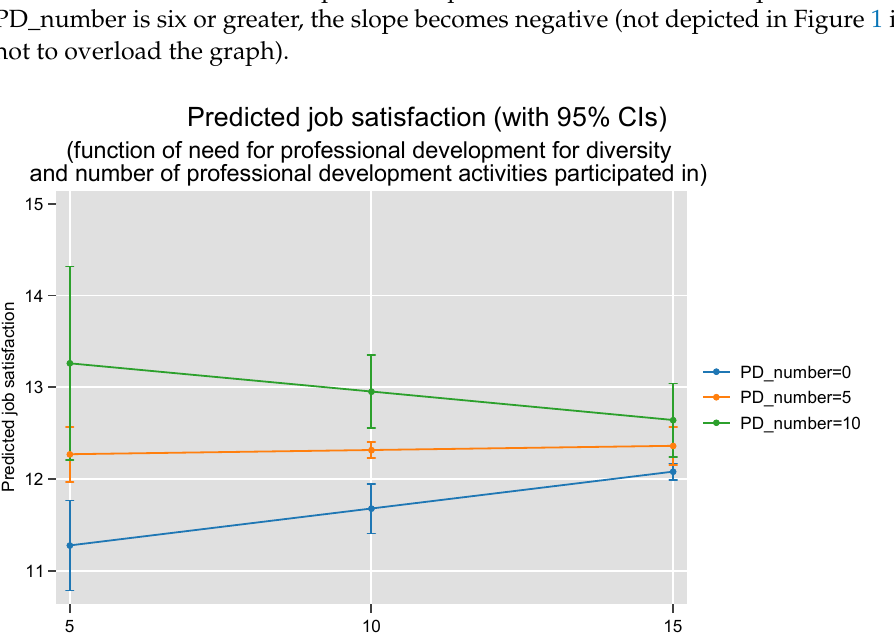
Figure 2. Predicted job satisfaction as a function of the need for professional development in subject matter and pedagogy and the number of professional development activities participated in. In order to investigate whether the impact of the number of professional develop- ment activities a teacher participated in (PD_number) has a linear (strictly increasing) ef- fect on job satisfaction, we re-estimated the model and included PD_number as 10 sepa- rate dummies (both as main effect and as moderator on t3pdiv and t3pdped) instead of treating it as a continuous variable, as we did in Table 3. Detailed estimation results of this model are presented in Table A1 in Appendix A. Figure 3 depicts the relationship between (the individual dummies of) PD_number and predicted job satisfaction: it clearly shows that job satisfaction tends to increase up to eight professional development activities participated in. For 9 and especially 10 activities,